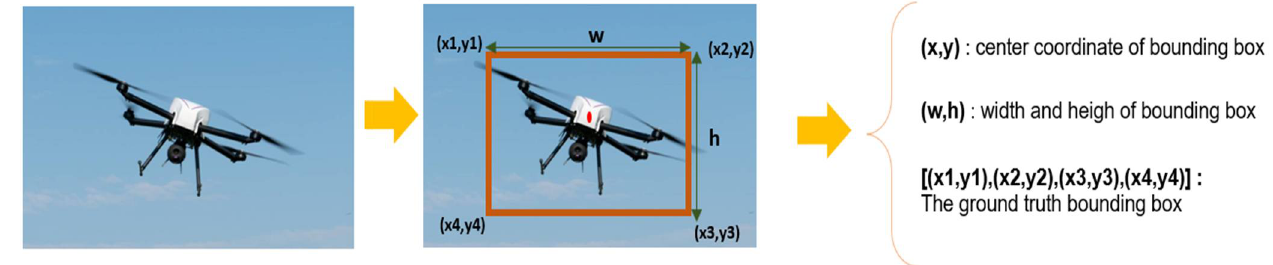
Figure 7. Ground truth bounding box sketch.